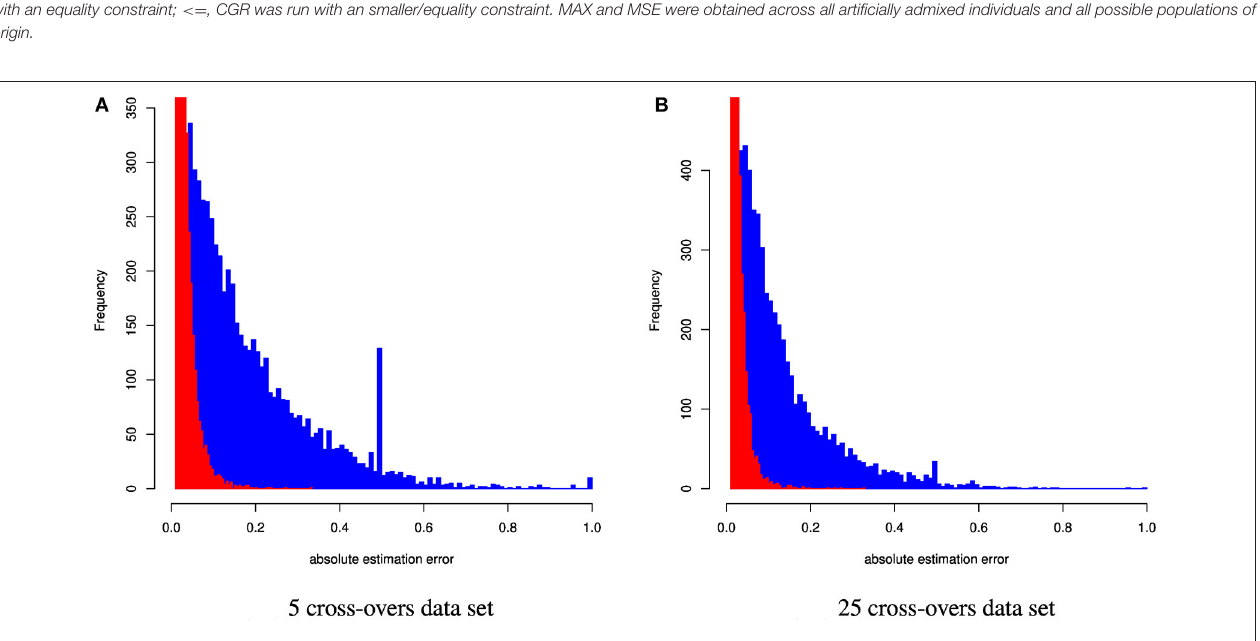
cross-overs, whereas for CGR this parameter was 0.33 for both data sets. The pattern for the mean squared estimation error was similar. For ADMIXTURE the error decreased from 0.03 to